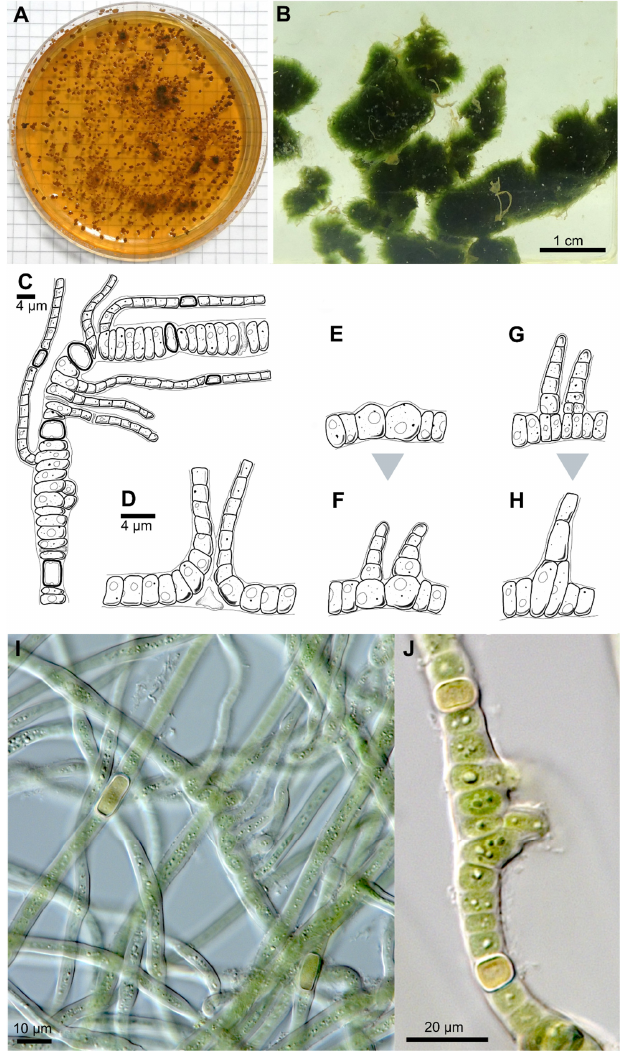
Figure 1. Photographs and drawing of Symphyonema bifilamentata . A One-year-old culture on Figure standard BG11 agar with segregated brownish to orange substance that stained the medium. B